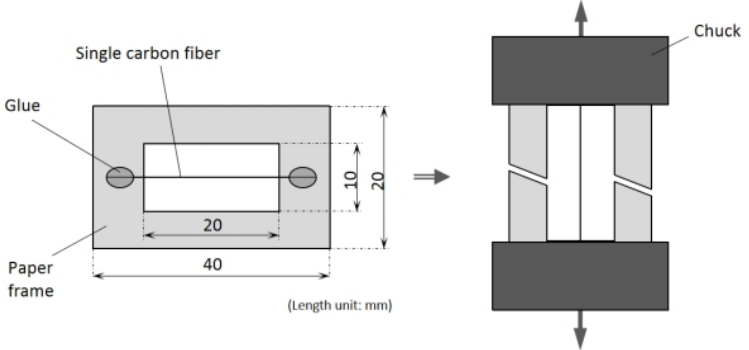
Figure 2. Schematic for the single fiber tensile testing.